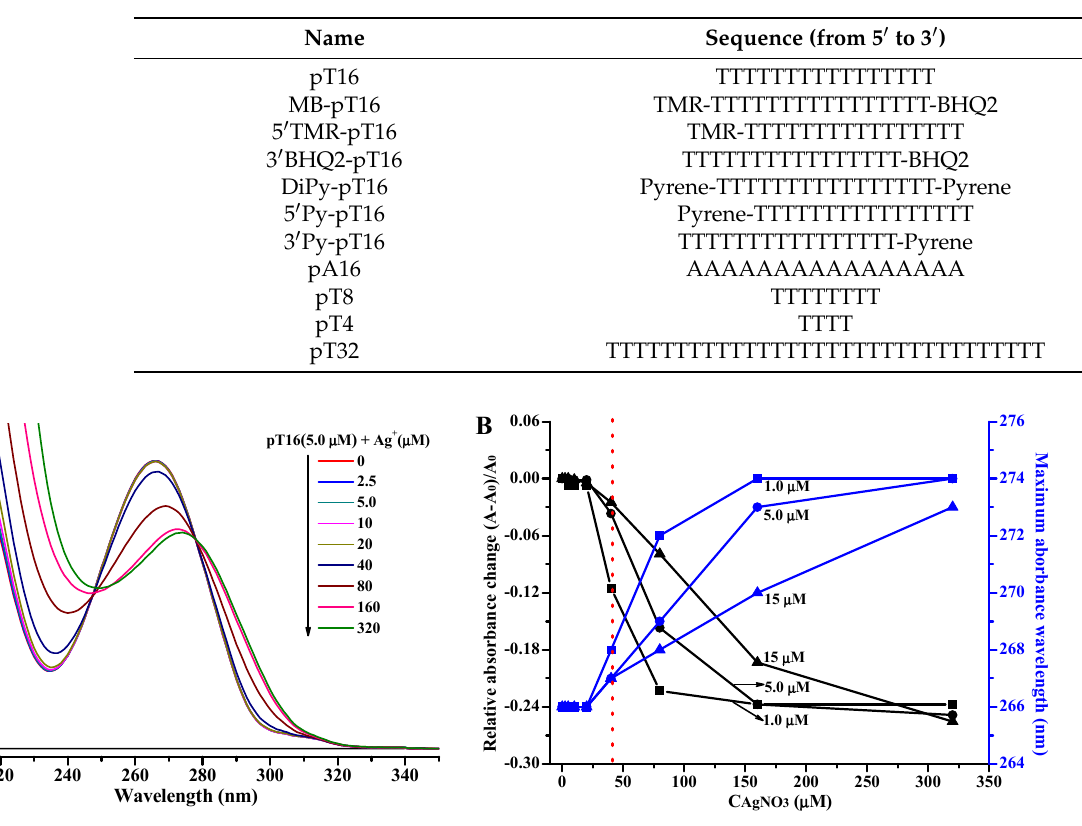
Table 1. The names, sequences, and modifications of the DNA oligonucleotides presented in this work.